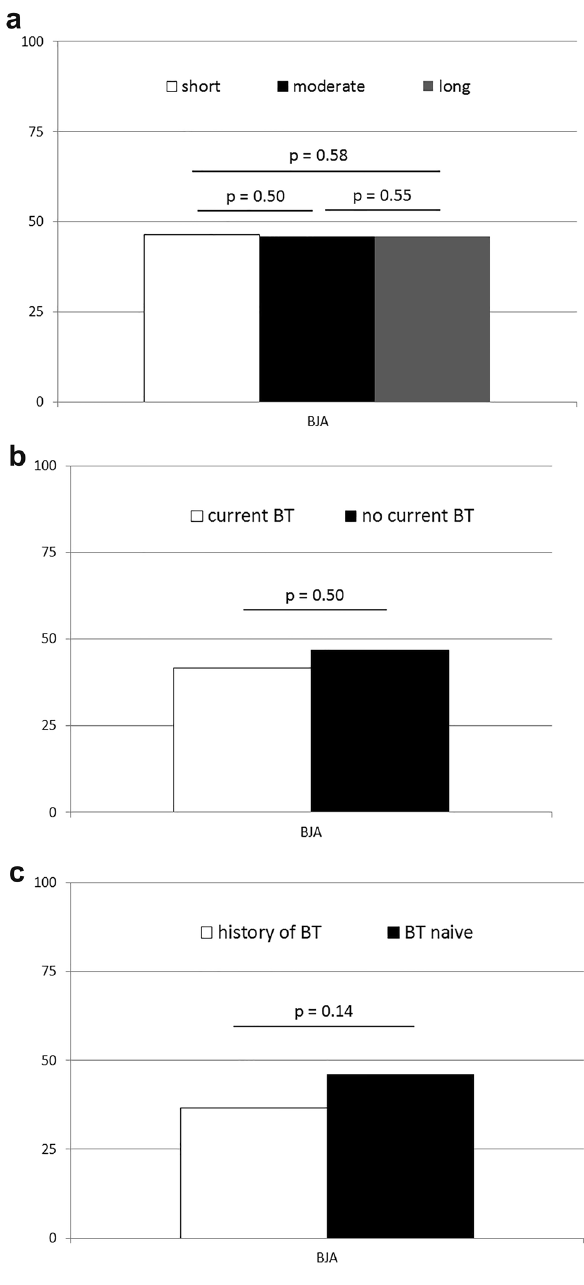
Figure 3. Prevalence of bamboo joint-like appearance (BJA) of the stomach in subgroups of patients with Crohn’s disease divided according to duration of the disease and treatment with biological therapy (BT). Comparison of BJA prevalence (expressed in percentage) between: ( a ) patients with short (up to 1 year), moderate (1–5 years) and long-term (> 5 years) course of the disease; ( b ) patients treated with or without BT upon recruitment to the study; and ( c ) patients with any history of BT and those who have never had any BT. p —level of